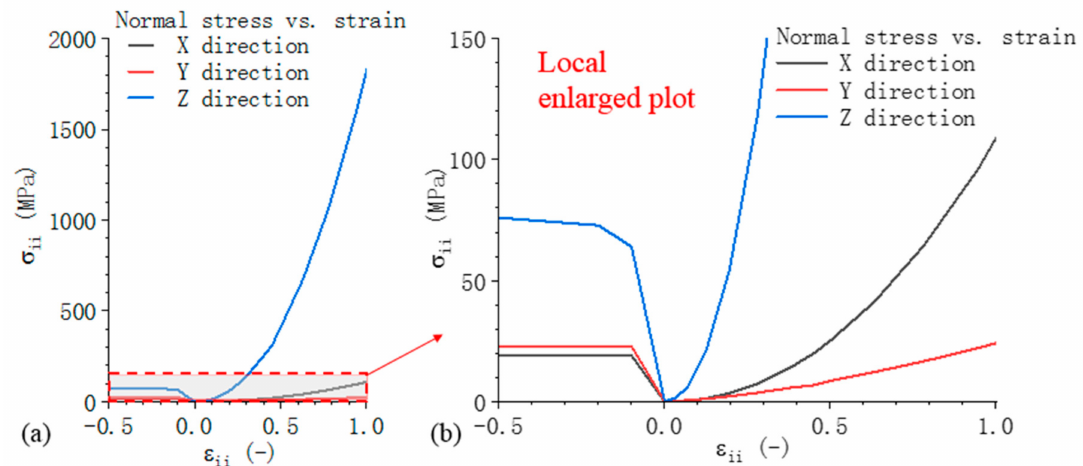
Figure 6. Hardening curves of three major directions: ( a ) whole plot; ( b ) local enlarged plot.